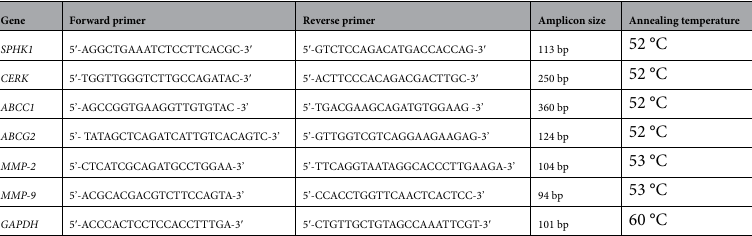
Table 1. List of primers designed and their sequences